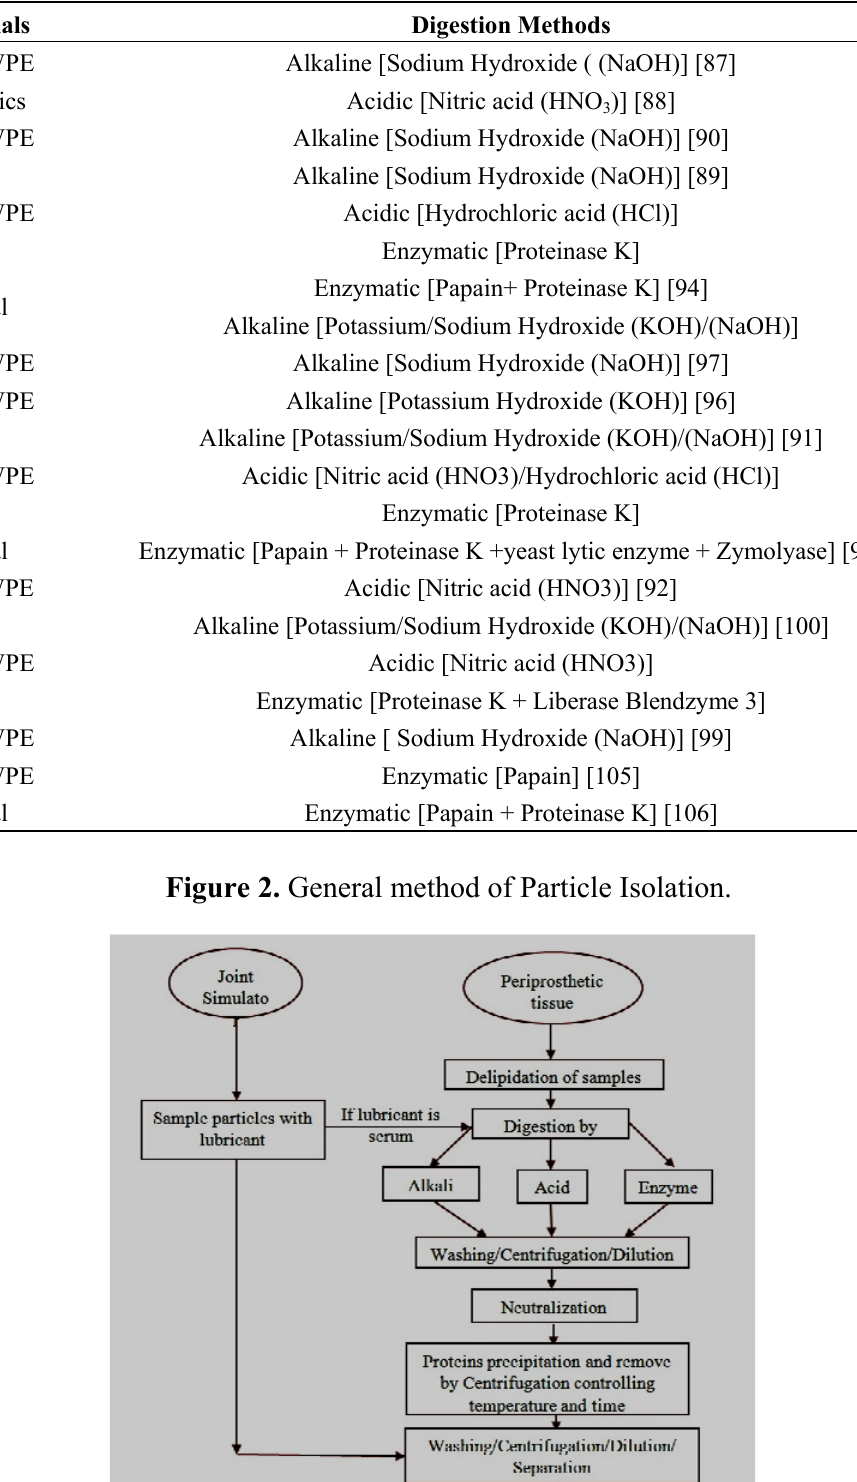
Table 1. Protocols for particle isolation.